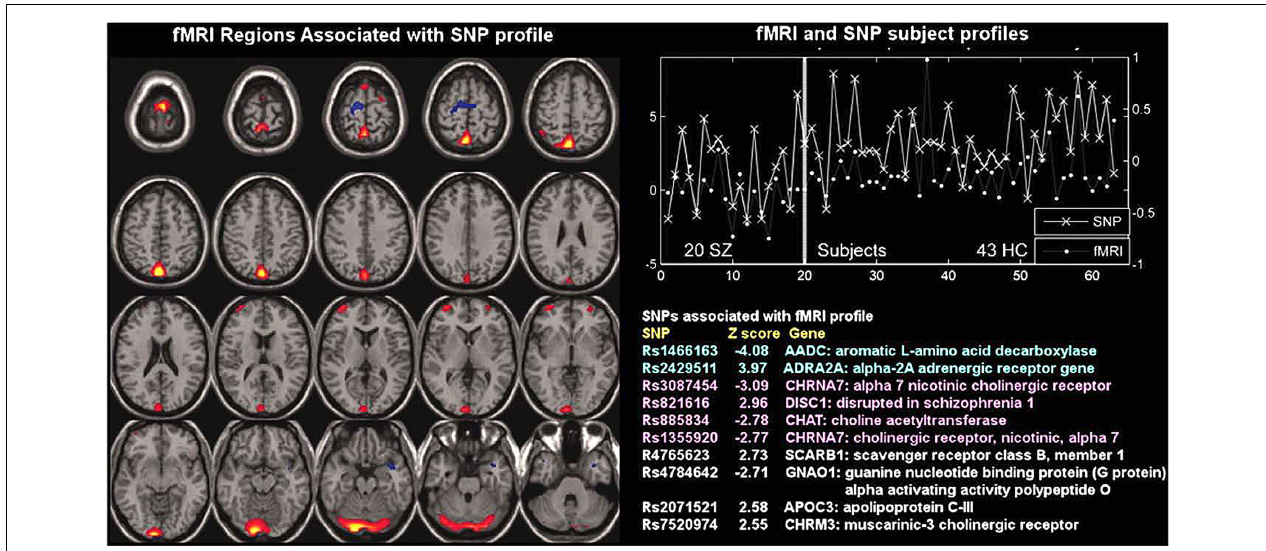
FIGURE 5 | Functional magnetic resonance imaging/SNP parallel ICA from Liu et al. (2009): parallel ICA provides an fMRI part (left) and a SNP part (bottom right) in addition to a correlated subject profile for both fMRI and SNP data (top